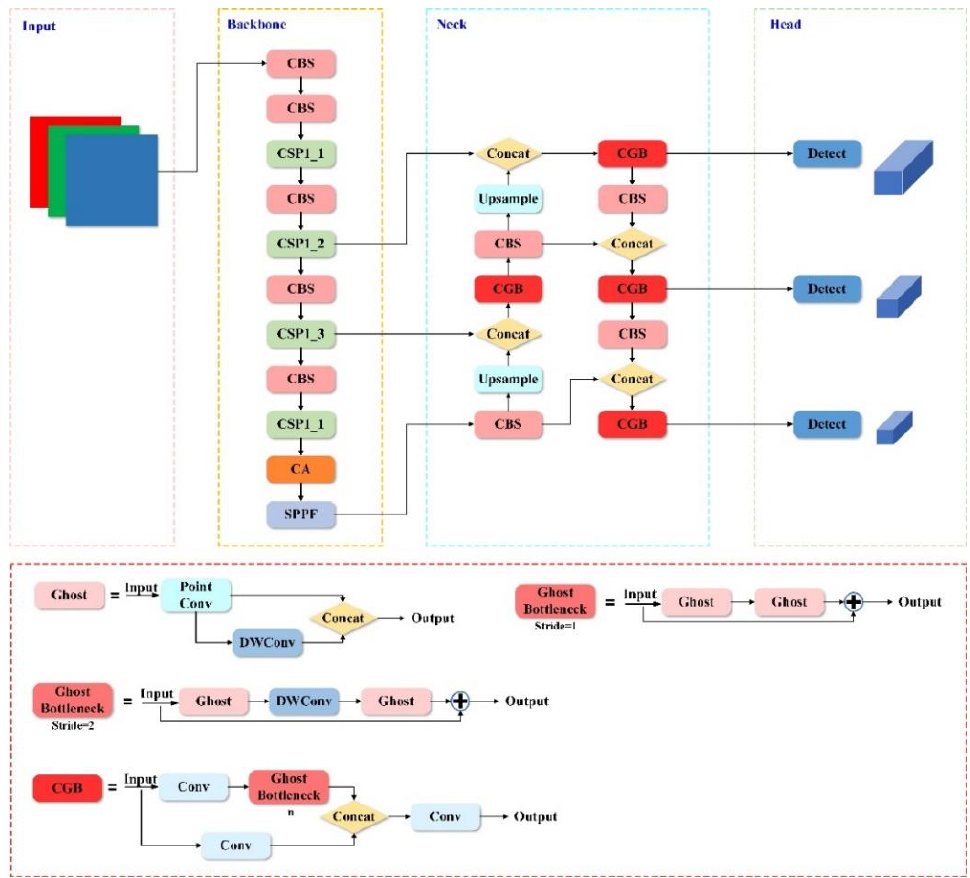
Figure 6. Structure of improved YOLOv5 network model.